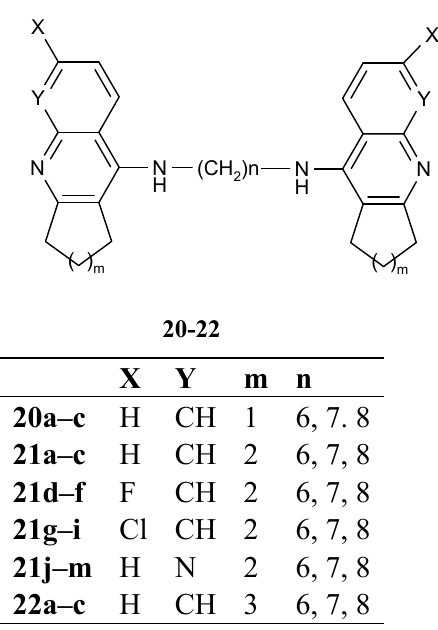
Figure 9. Bis -tacrine congeners 20–22